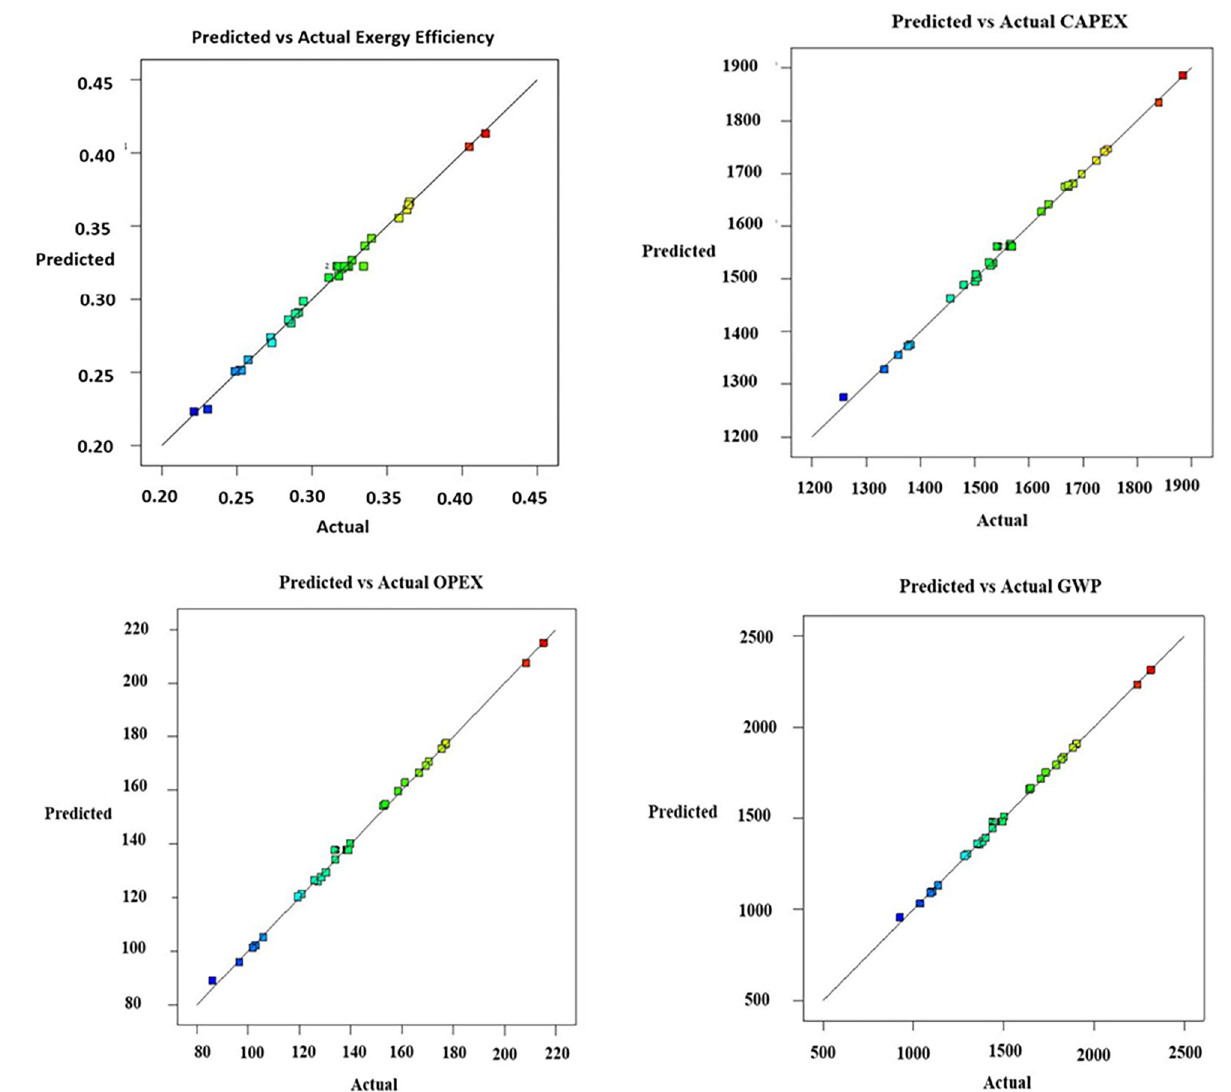
Fig 4. Predicted vs. actual values of a) Exergetic Efficiency, b) CAPEX, c) OPEX, and d)